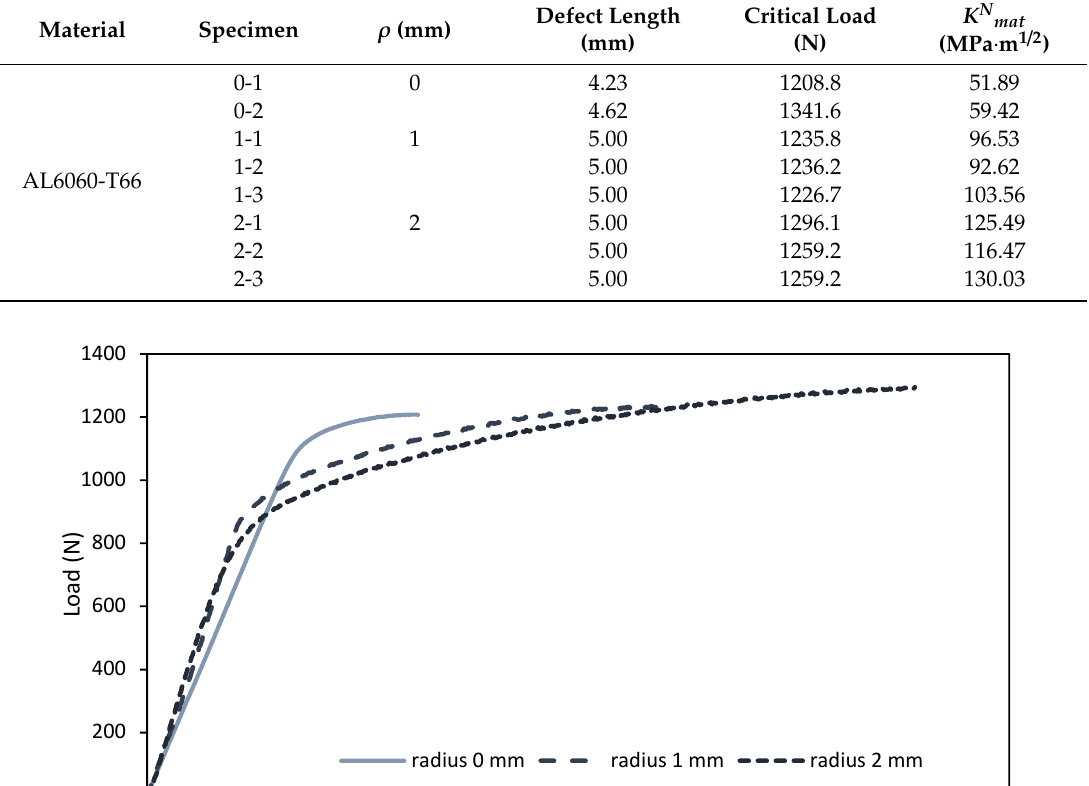
Table 4. Experimental results obtained in SENB specimens. K N mat in cracked specimens correspond to the material fracture toughness K mat .